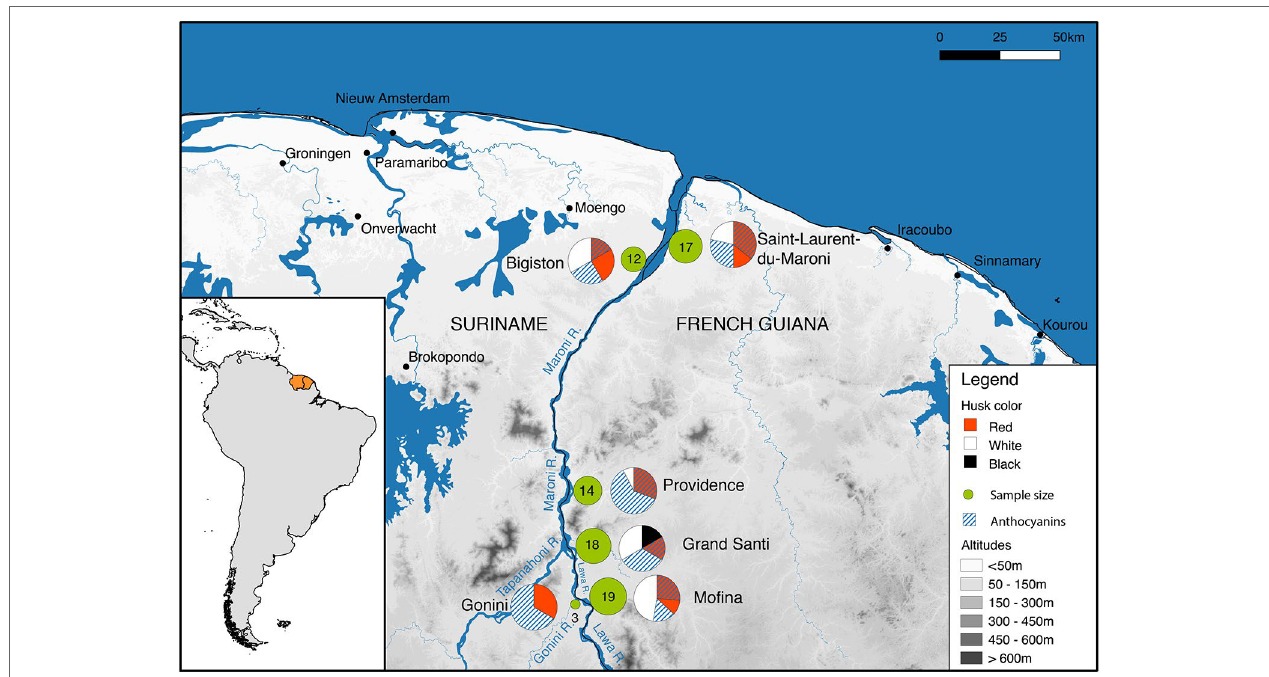
FIGURE 1 | Study area. Fieldwork locations are represented with green circles, whose size is proportional to the number of samples. The pie charts illustrate the proportion of samples with different husk colors and anthocyanins. Metadata for this map are provided in Supplementary Table